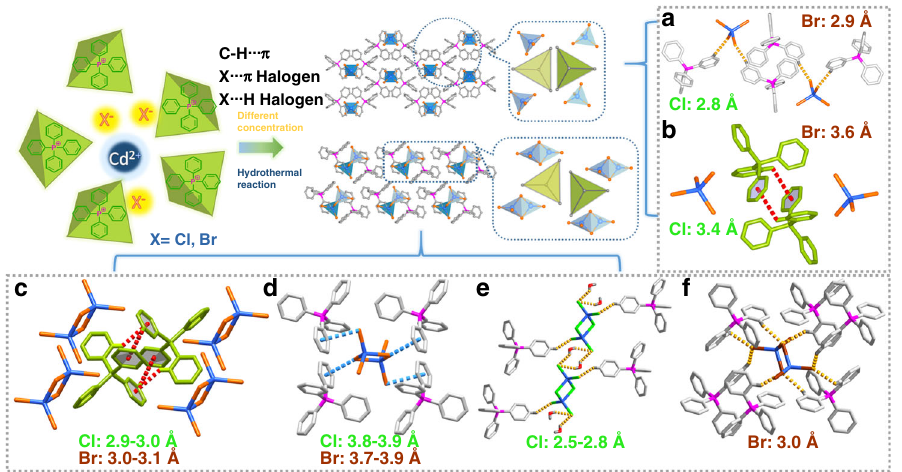
Fig. 1 Synthetic schematic diagram and intermolecular forces. a , b (Ph 4 P) 2 CdX 4 and c , d (Ph 4 P) 2 Cd 2 X 6 , which show the hydrogen bonds as well as C ‒ H··· π and X··· π interactions within (Ph 4 P) 2 Cd 2 Cl 6 and (Ph 4 P) 2 Cd 2 Br 6 . a – f The orange parts refer to the halogen atoms Cl or Br, blue parts refer to the Cd atoms, the green parts refer to the Cl atoms in the fi gure, the brown parts refer to the Br atoms, the purple parts refer to the P atoms, and the gray parts refer to the C atoms. The tetraphenylphosphine units drawn in green refer to the cationic pairs in the crystal, echoing the green tetrahedron in the synthesis